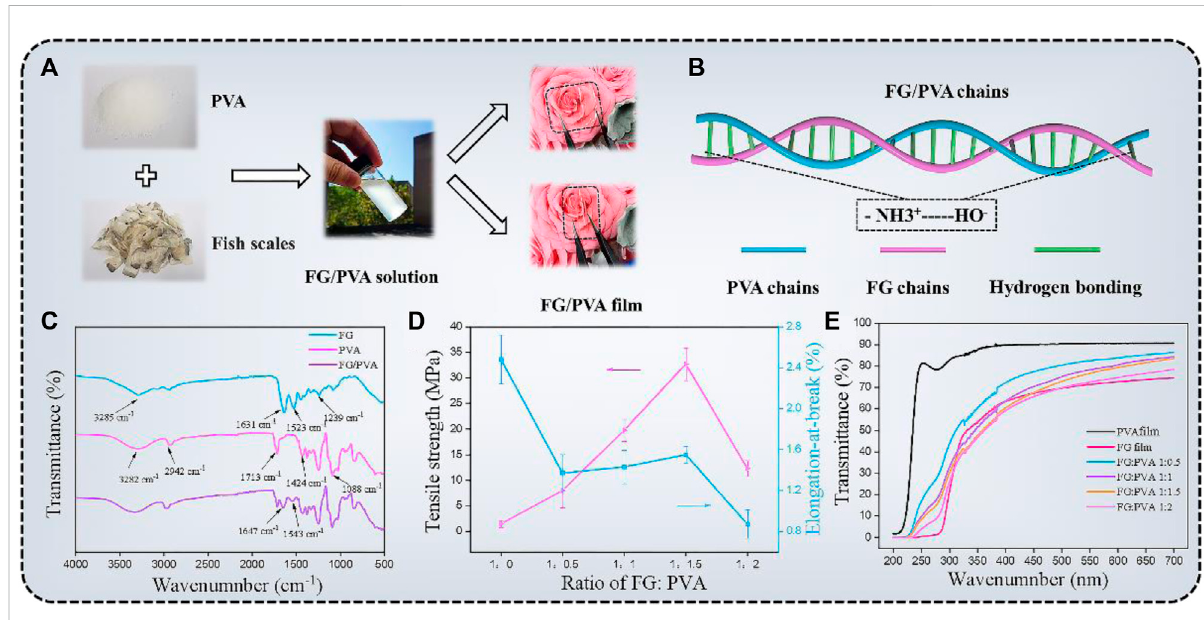
FIGURE 3 (A) PreparationprocessoftheFG/PVA fi lm. (B) TheinteractionmechanismbetweenFGandPVA. (C) FT-IRspectraofFG,PVA,andFG/PVA fi lms. The values of the tensile strength (TS), elongation-at-break (EB), and transmittance of different fi lms (D,E)